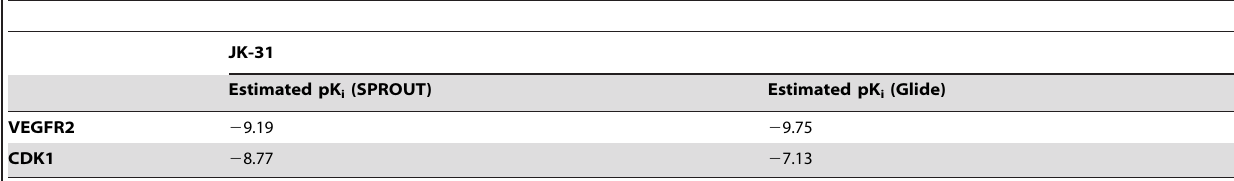
Table 1. Estimated binding affinities (pK i values) of JK-31 to VEGFR2 and CDK1 kinase domains in silico , as predicted using SPROUT and Glide programs (see